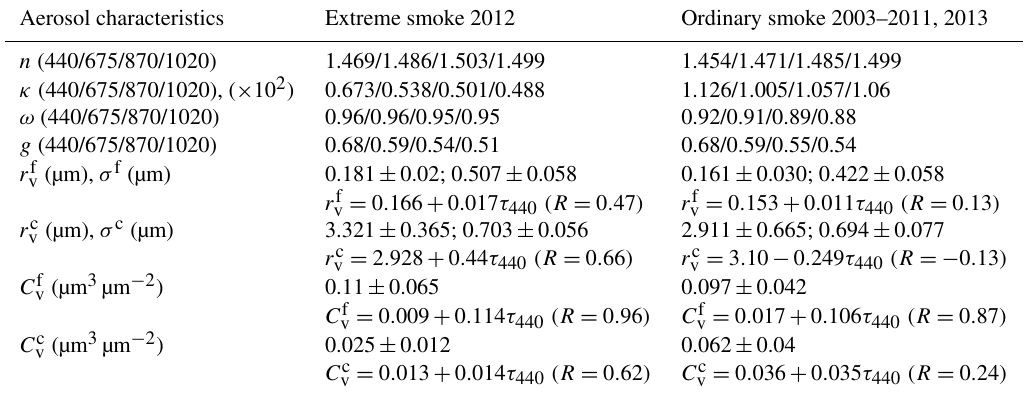
Table 3. Optical and microphysical properties of biomass burning aerosol retrieved from AERONET Tomsk sites (Tomsk,